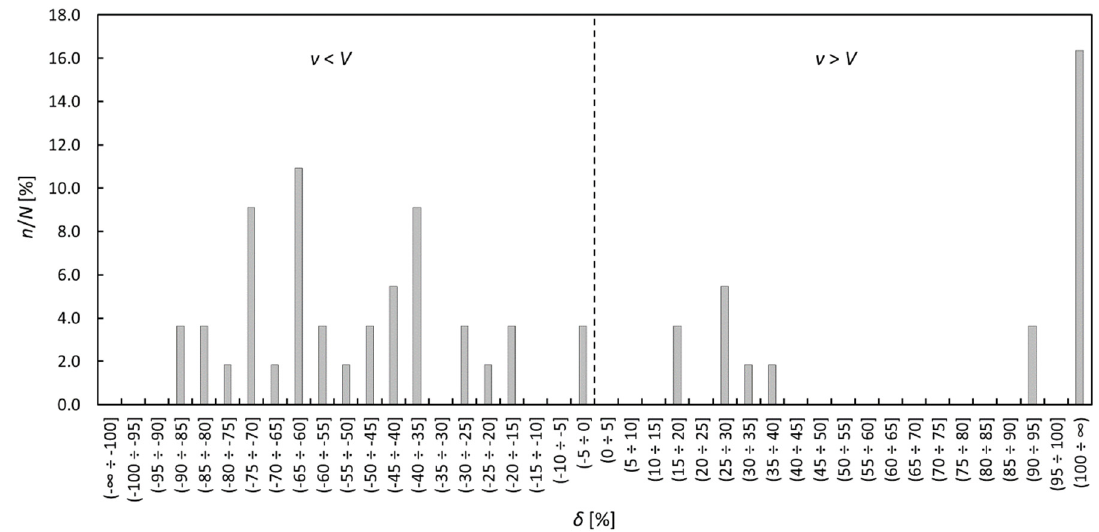
Figure 6. Velocity deviation distribution in the tube bundle for the clean heat exchanger.